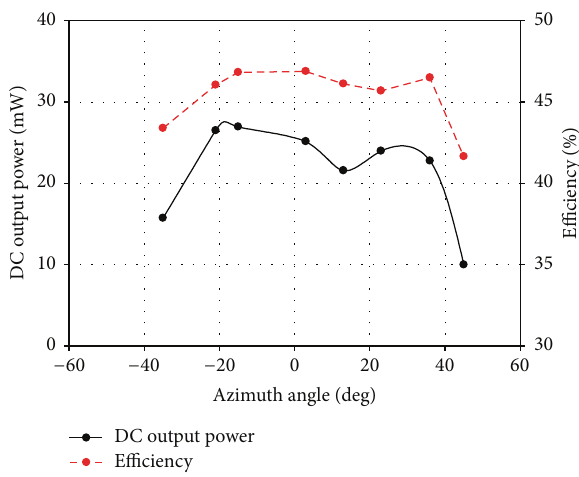
Figure 8: Measured RF-DC conversion efficiency and DC output power when the beam is